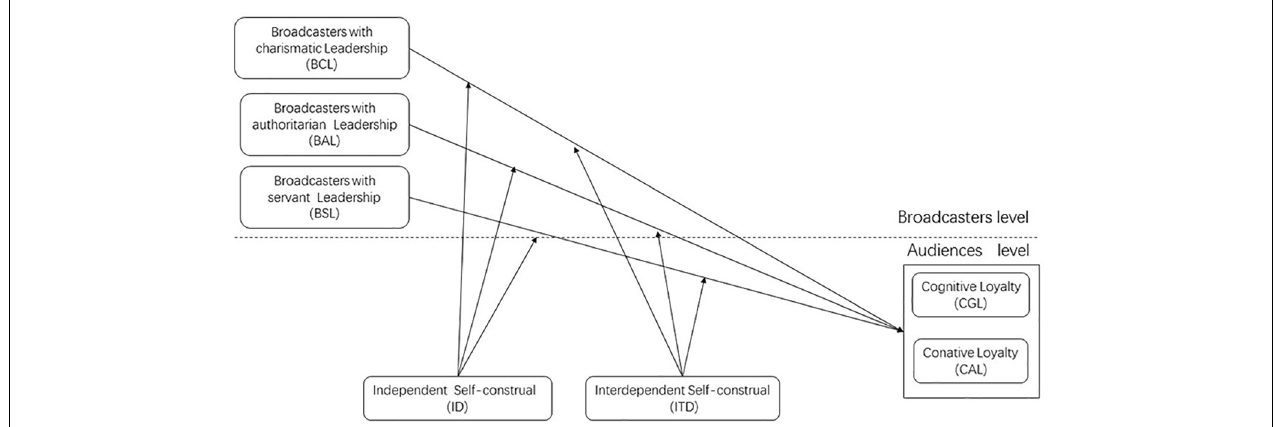
FIGURE 1 | The conceptual